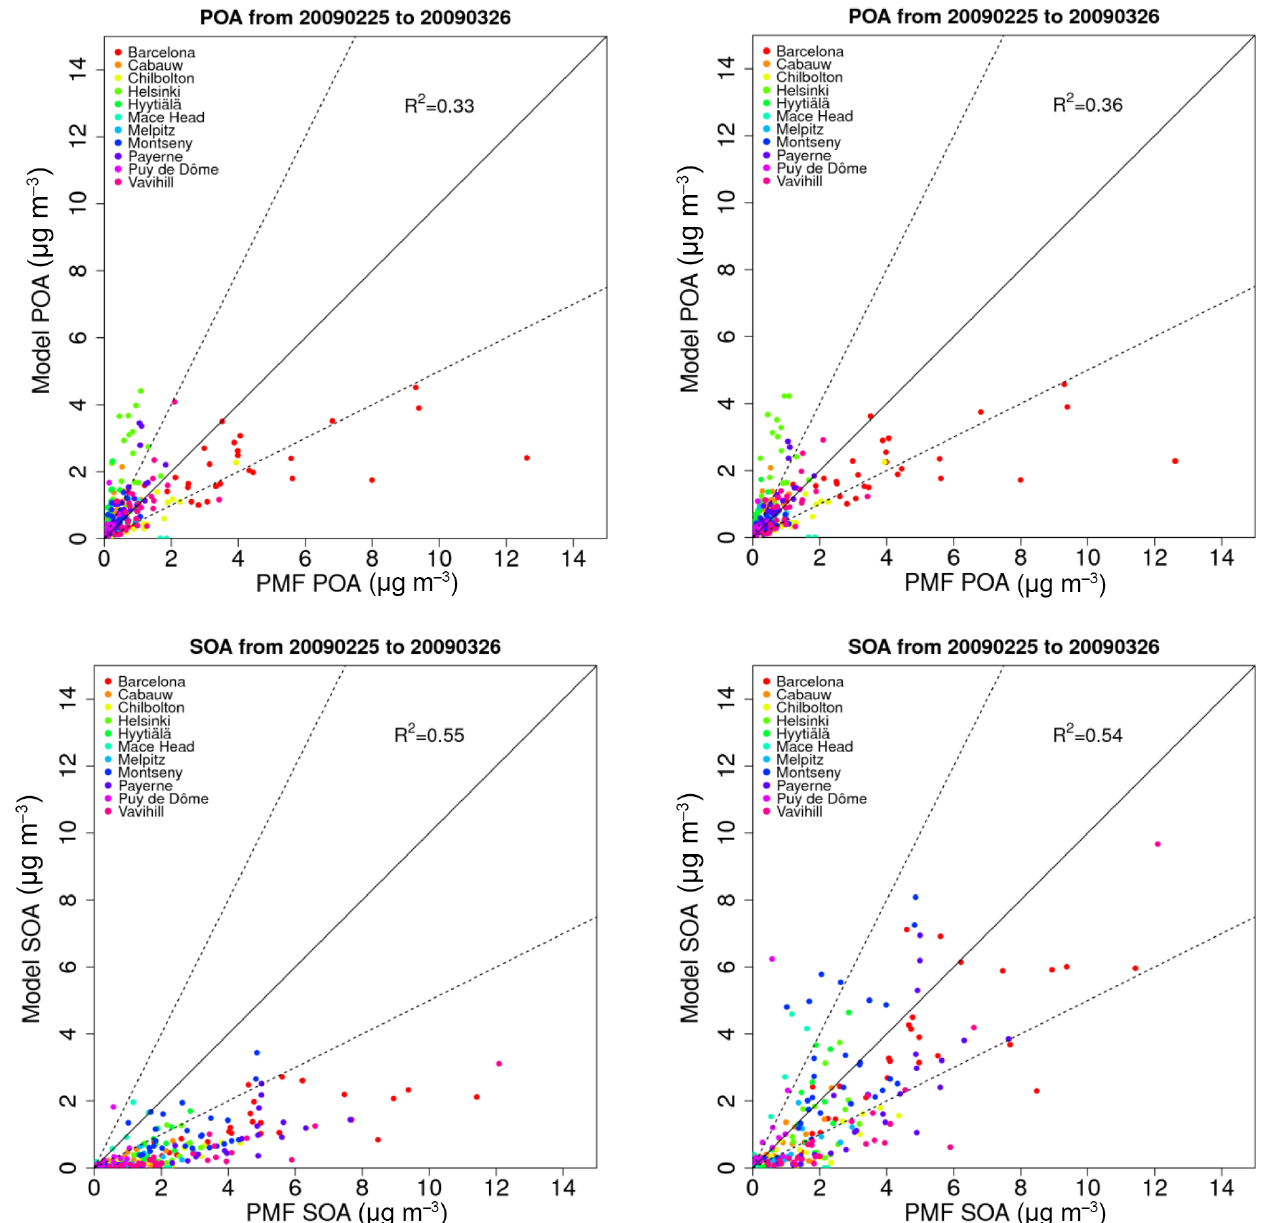
Figure 5. Daily average scatter plots of POA and SOA concentrations at 11 AMS sites for February–March 2009 in VBS_BC (Ciarelli et al., 2016) (left) and VBS_BC_NEW (right). Solid lines indicate the 1:1 line. Dotted lines are the 1:2 and 2:1